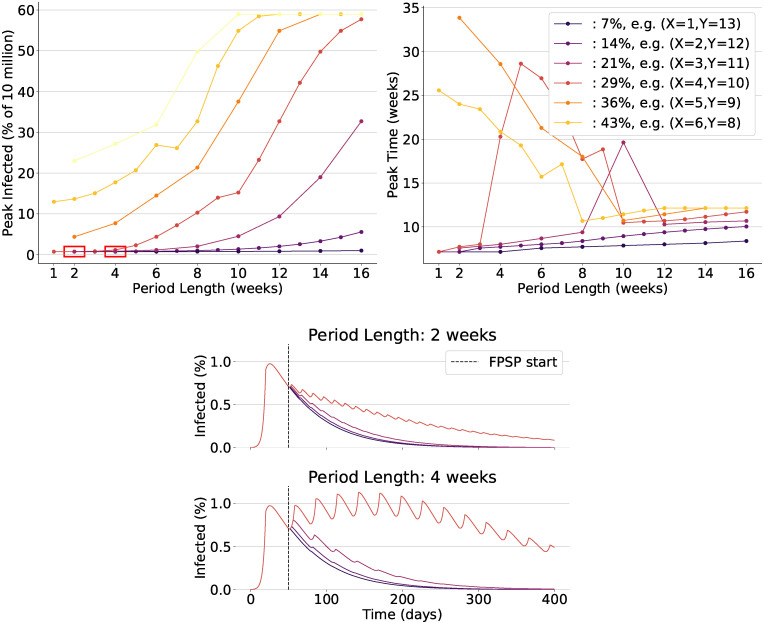
Some instances of analysis of infection over time as a function of FPSP duty-cycle and
associated modes of behaviours of the epidemic.In all diagrams showing peak-values and peak-times, each point corresponds to a single policy and all policies have a period which is a multiple of seven days. Colours distinguish duty-cycles as indicated in the top-right panel. (Top-Left) Shows that infected peak-values increase with duty-cycle for fixed period lengths and, notably, with increased period length for fixed duty-cycles. (Top-right) shows that peak-times are small for policies attaining small and large peak values, while they are inversely related to the peak values for policies attaining middle peak values. (Bottom) highlights the time-behaviour of the epidemic for two choices of the period and four choices of the duty-cycle. These time-trajectories correspond to policies belonging to the two red rectangles shown at the bottom-left of the top-left panel.